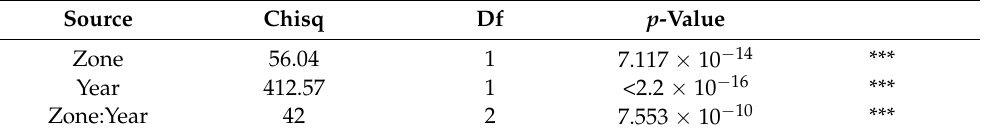
Table 5. Analysis of Deviance Table (Type II Wald chi-square tests) in the fitted negative binomial regression model for the total number of insects. Source Chisq